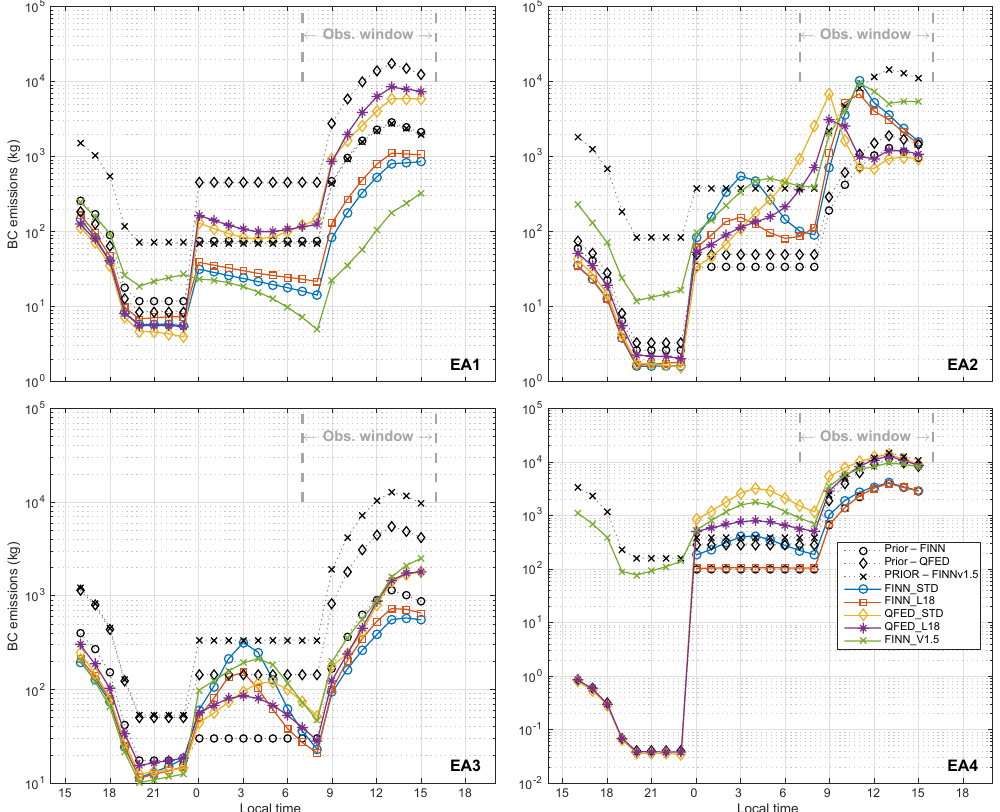
Figure 9. Hourly BB diurnal emission patterns for the four EAs and all inversion scenarios for 22 June, 00:00–23:00Z, with the time shown in LT. The priors are shown as black lines, while the posteriors from specific inversion scenarios are shown in color. Note that FINNv1.0 did not have any fires in EA4 on 21